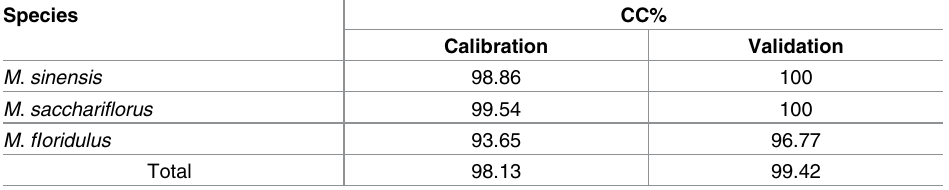
Table 4. Calibration and prediction results for the classification of the Miscanthus species according to the model developed by